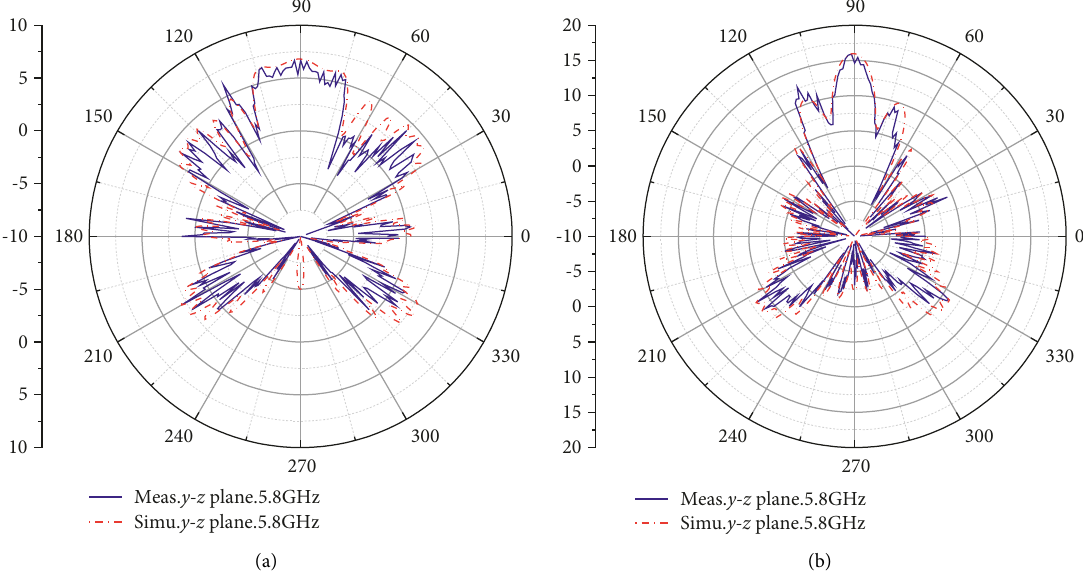
Figure 14: Antenna radiation patterns without (a) and with (b) dielectric lens. A good agreement between numerical simulations and measurements is